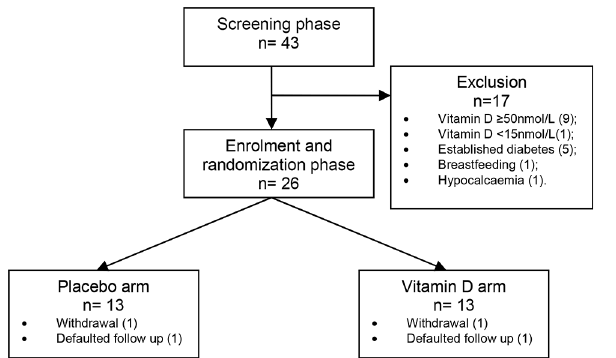
Fig 1. Flow chart of study